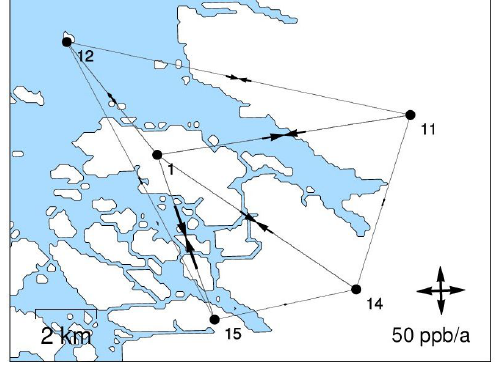
Figure 9. Strains along baselines in the outer